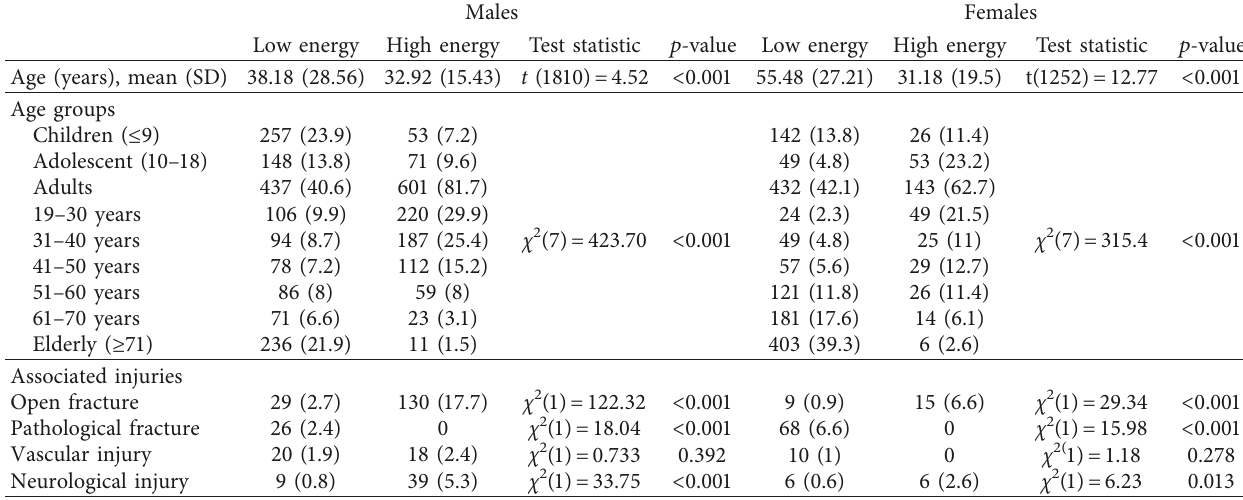
Table 6: Bivariate analysis between genders and age groups according to low- and high-energy injuries, n � 3066. Males Females Low energy High energy Test statistic p -value Low energy High energy Test statistic p -value